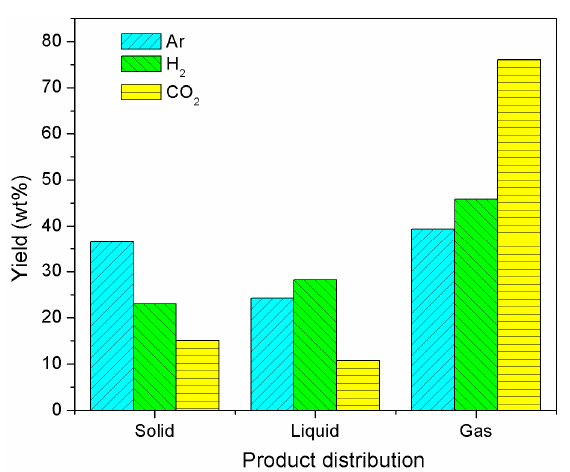
Figure 2. Products (solid carbon, liquid, and noncondensable gas) distribution of kraft lignin thermally decomposed using three different atmospheres at 1000 °C for 1 h.